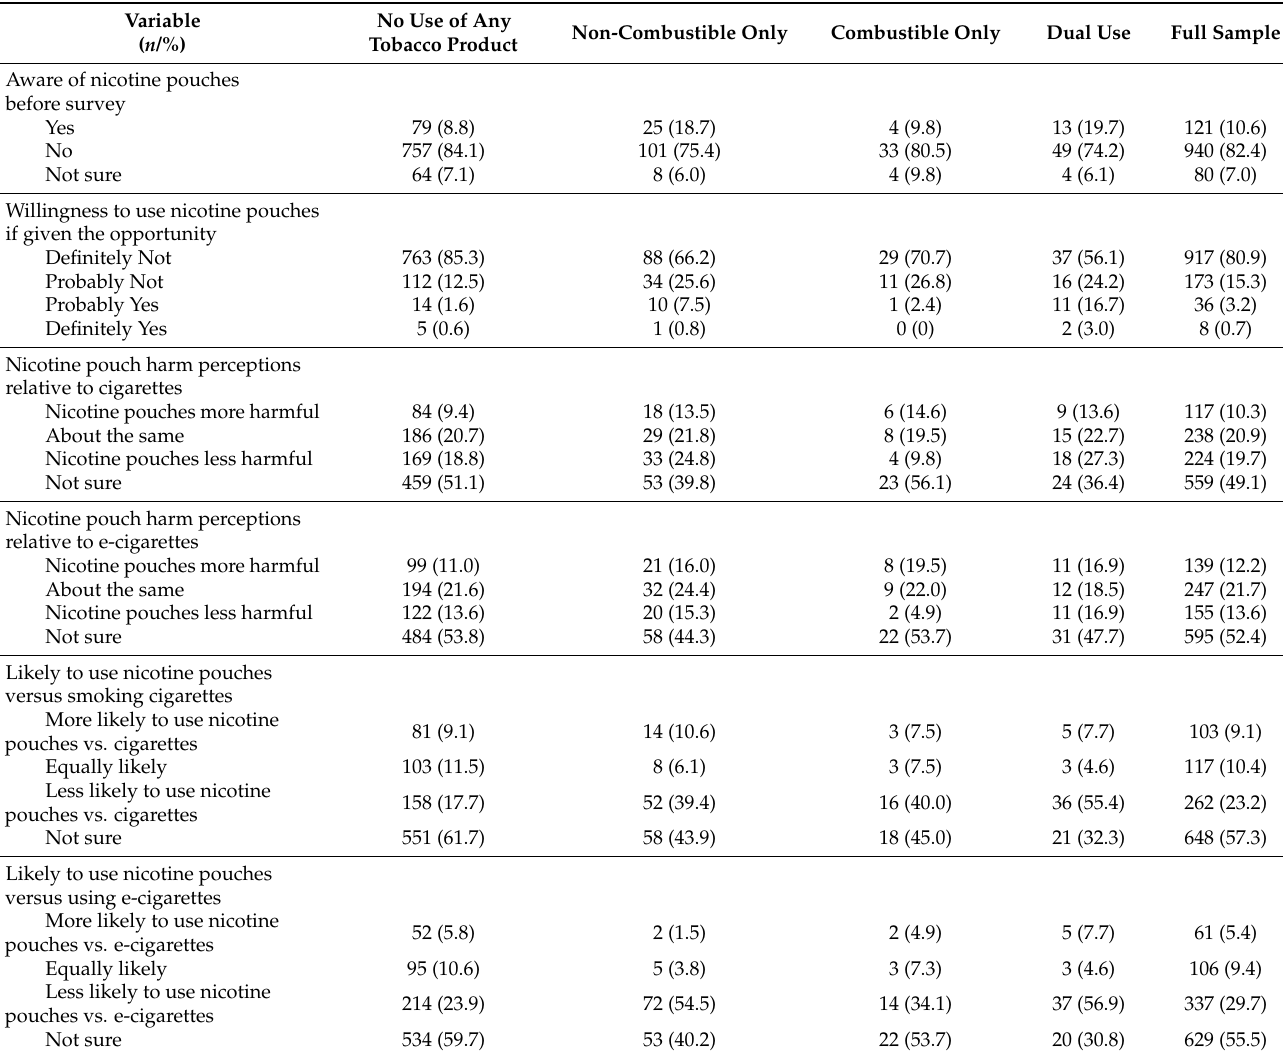
Table 2. Nicotine pouch use willingness and perceptions by tobacco product use